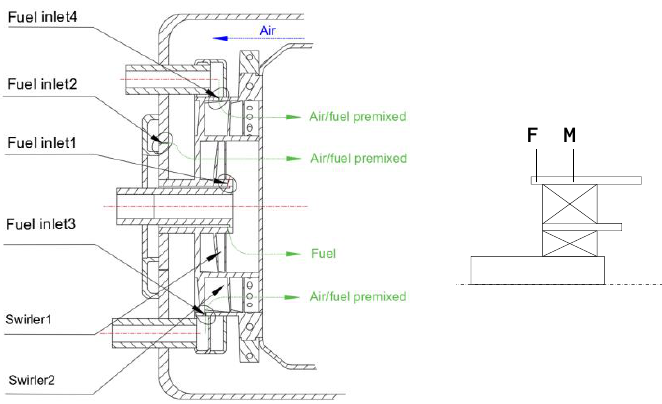
Figure 2. Combustor head with four fuel inlets and two swirlers. Table 2. The combustor structure parameters and study method.